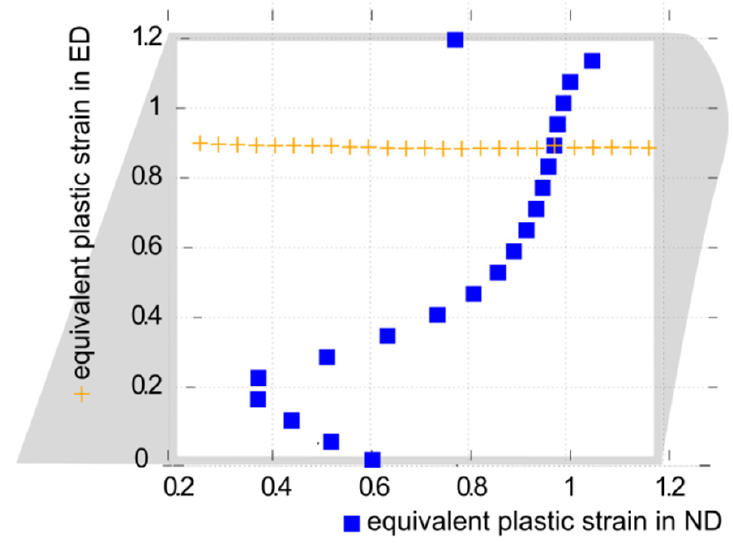
Figure 11. Equivalent plastic strain in central region of the billet along ND and ED at the 21 points indicated in Figure